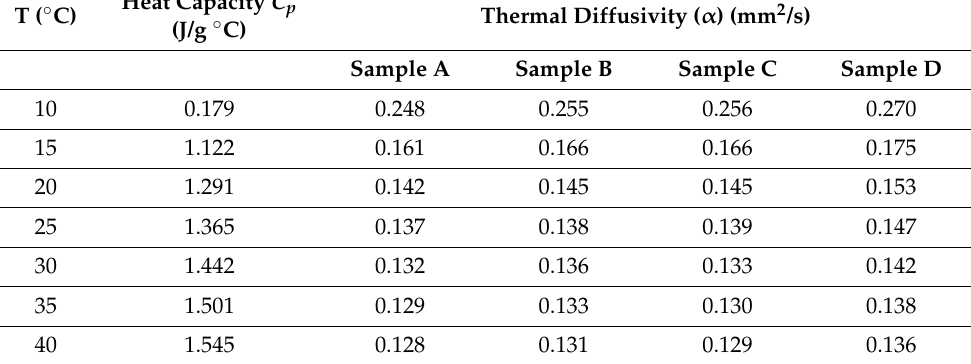
Table 3. Thermal diffusivity values of the different insulation composite